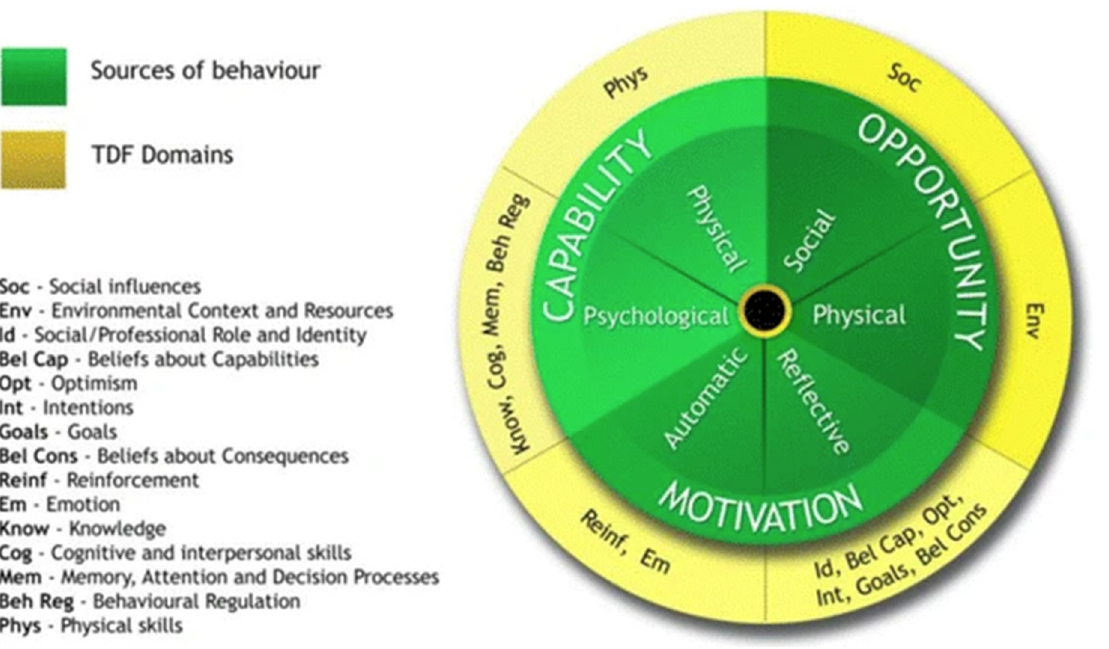
Figure 3. The three sources of behaviour and the TDF Domains of the Behaviour Change Wheel. “Adapted with permission from [47]. 2017, Lou “Adapted with permission from [47]. 2017, Lou Atkins”.